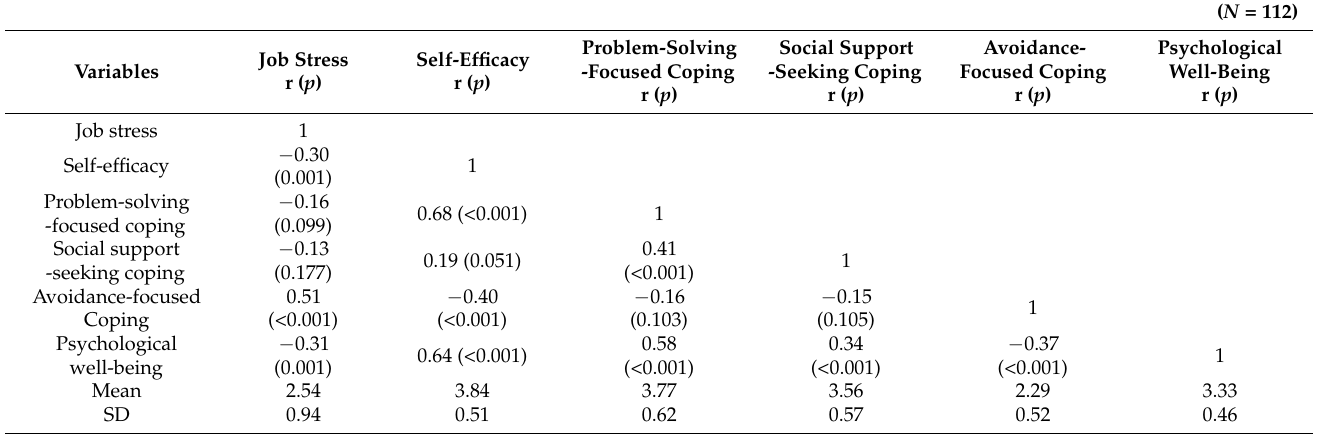
Table 2. Degree of job stress, self-efficacy, problem-solving-focused coping, social support-seeking coping, avoidance-focused coping and psychological well-being of participants and relations of the variables.